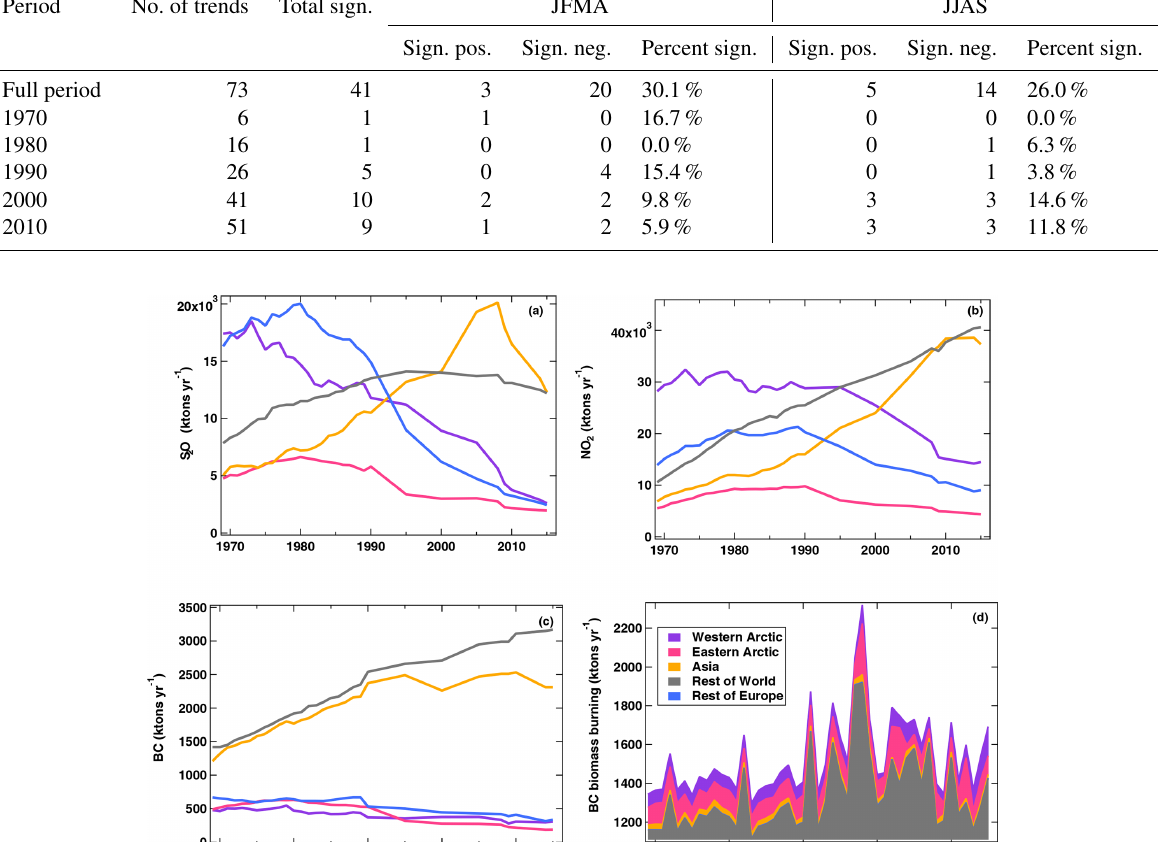
Figure 4. Anthropogenic emissions of SO 2 (a) , NO 2 (b) , BC (c) and BC from biomass burning (d) . Anthropogenic emissions are based on ECLIPSE v6B (Höglund-Isaksson et al., 2020). Data from before 1990 are based on CMIP6 (Hoesly et al., 2018; van Marle et al., 2017) scaled linearly to match ECLIPSE v6B. Biomass burning data are from CMIP6. The Western Arctic region refers to the following countries: USA and Canada; Eastern Arctic region: Kingdom of Denmark, Finland, Iceland, Norway, the Russian Federation and Sweden. The grouping follows the report of the Arctic Monitoring and Assessment Programme on short-lived climate forcers and refers to entire countries (AMAP,